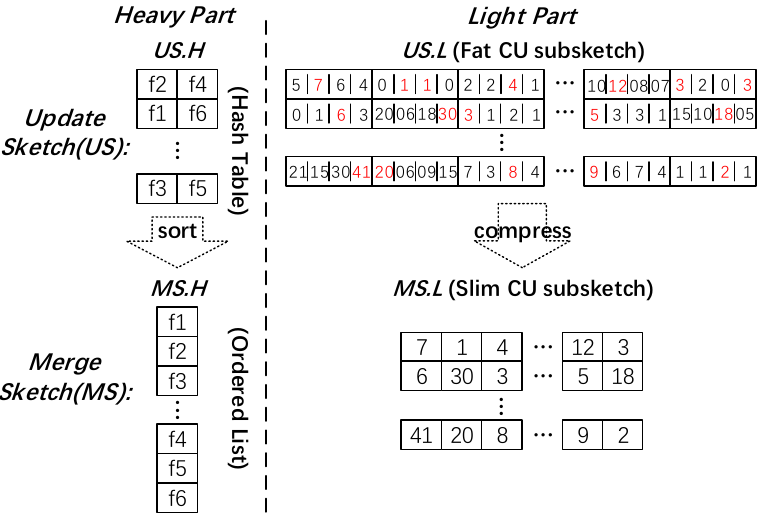
Figure 4. Data structures of Update Sketch and Merge Sketch. Note that each element of the heavy part is an ID–value pair to represent (flowID,